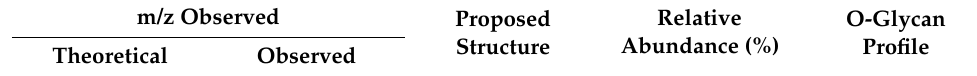
Table 2. O-glycan profile and relative abundance of HL-60, U937 and K562 cell lines.